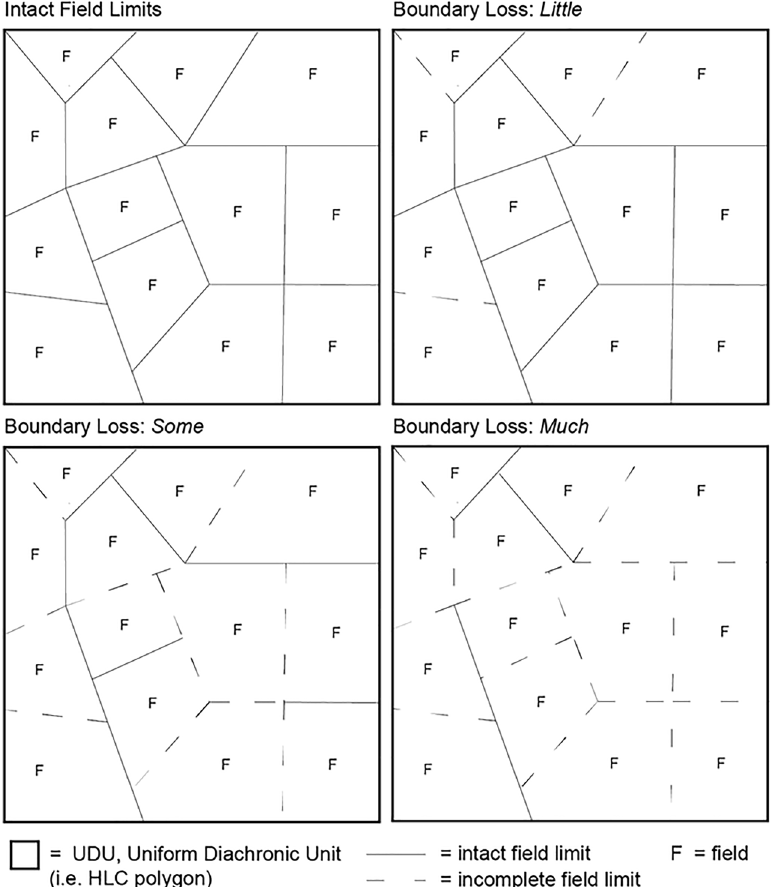
Figure 5. Schematic representation of the ‘Boundary Loss’ attribute used in the Historic Landscape Characterisation